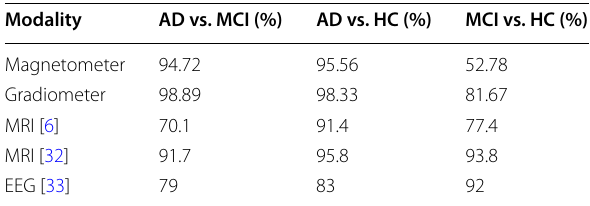
Table 2 Confusion matrix for the three‑way classification performance using the features derived from the left‑frontal region Test observation: